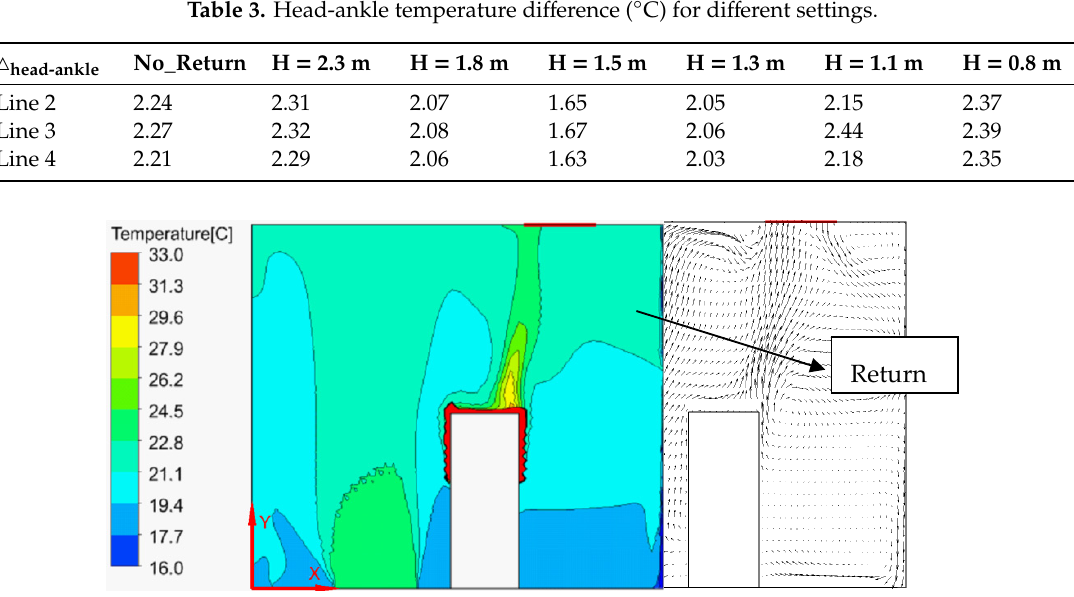
Figure 8. Temperature and Velocity distribution at the Plane Y = 0 (Case H = 1.5 m).